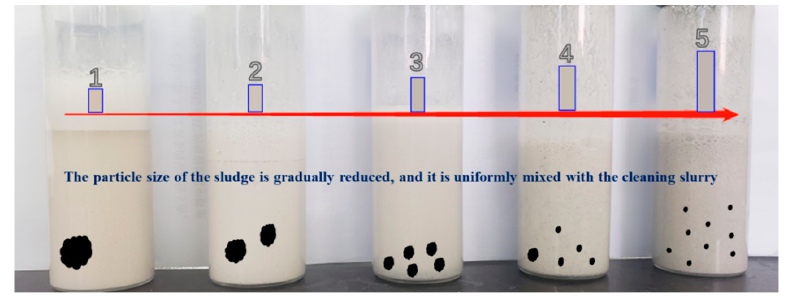
Figure 8. Color change in nano-cleaning fluid with processing